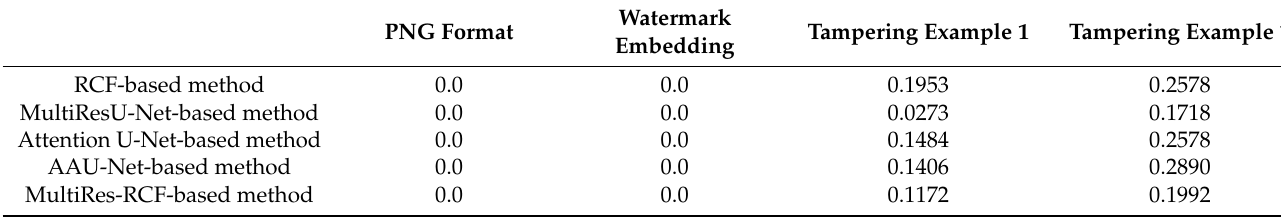
Table 3. Normalized Hamming distance of each algorithm in Table